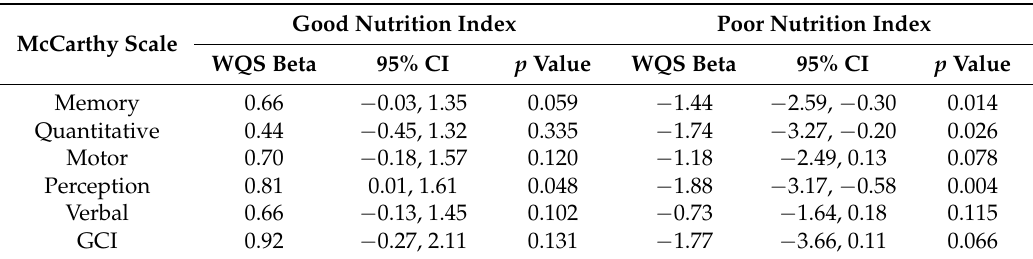
Table 4. WQS regression for childhood “good” and “poor” nutrition indices in relation to child McCarthy Scales scores.